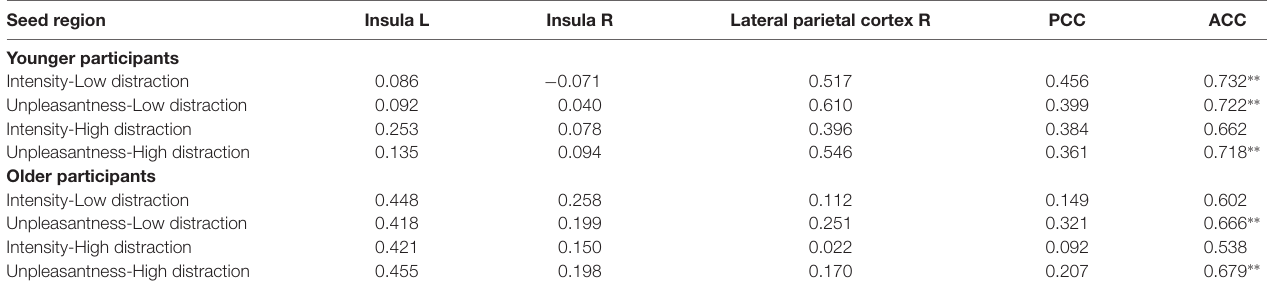
TABLE 4 | Pearson’s correlations between pain ratings and resting-state functional connectivity in both groups. Seed region Insula L Insula